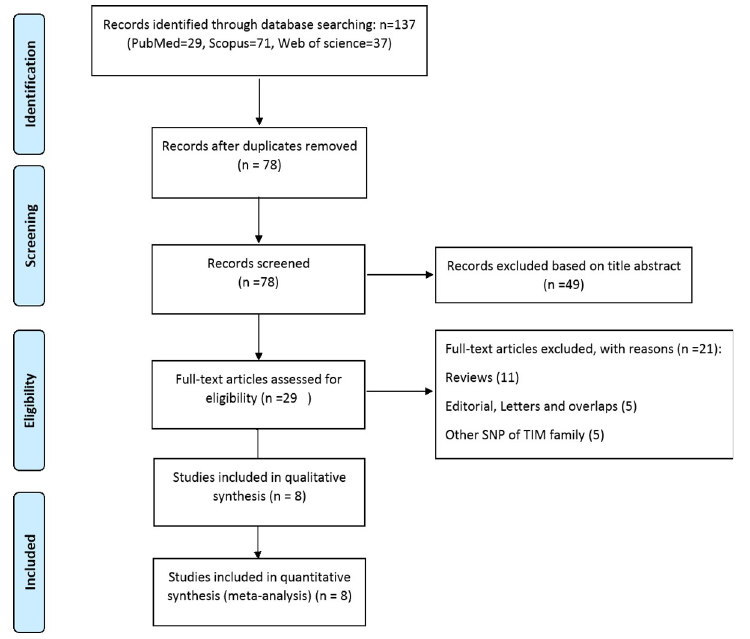
Fig 1. Flow diagram of study selection